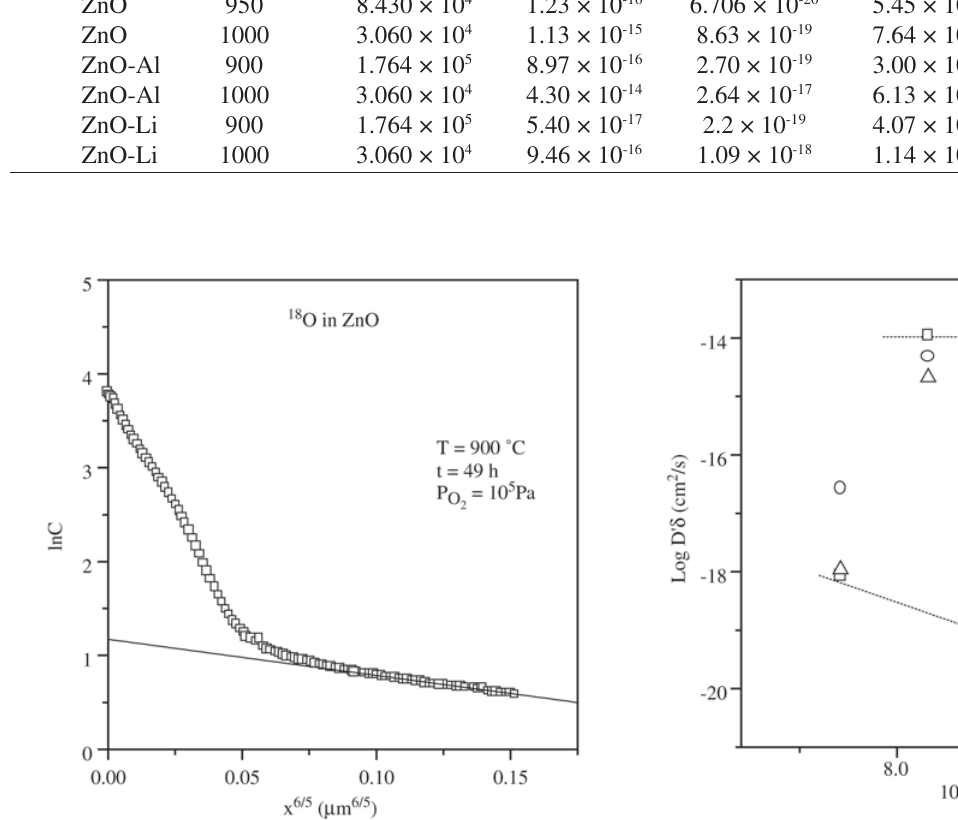
Figure 5. Comparison of the oxygen grain-boundary diffusion co- efficients determined in pure and doped ZnO.